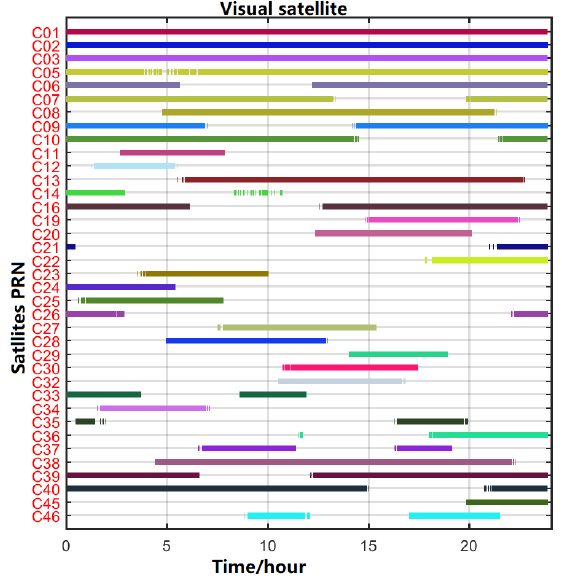
Figure 3. Satellite visibility of the WUH2 station and BDS satellite on 09 April 2020.